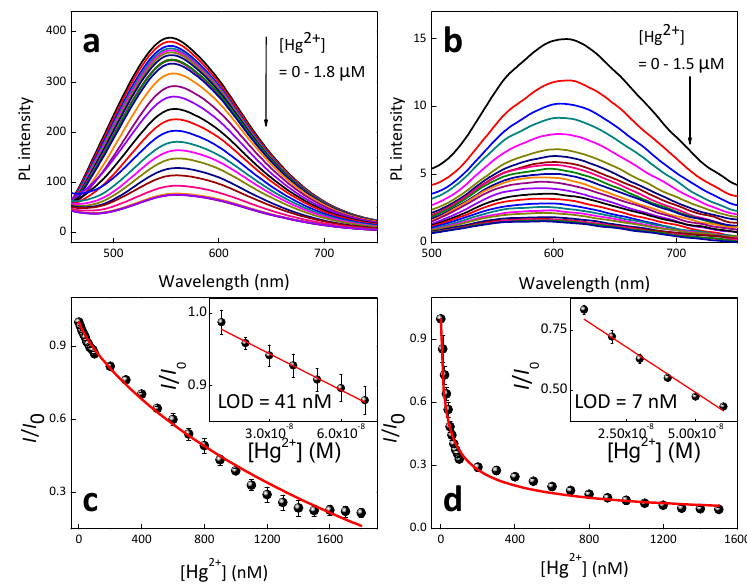
Sensors 2016 , 16 , 2082